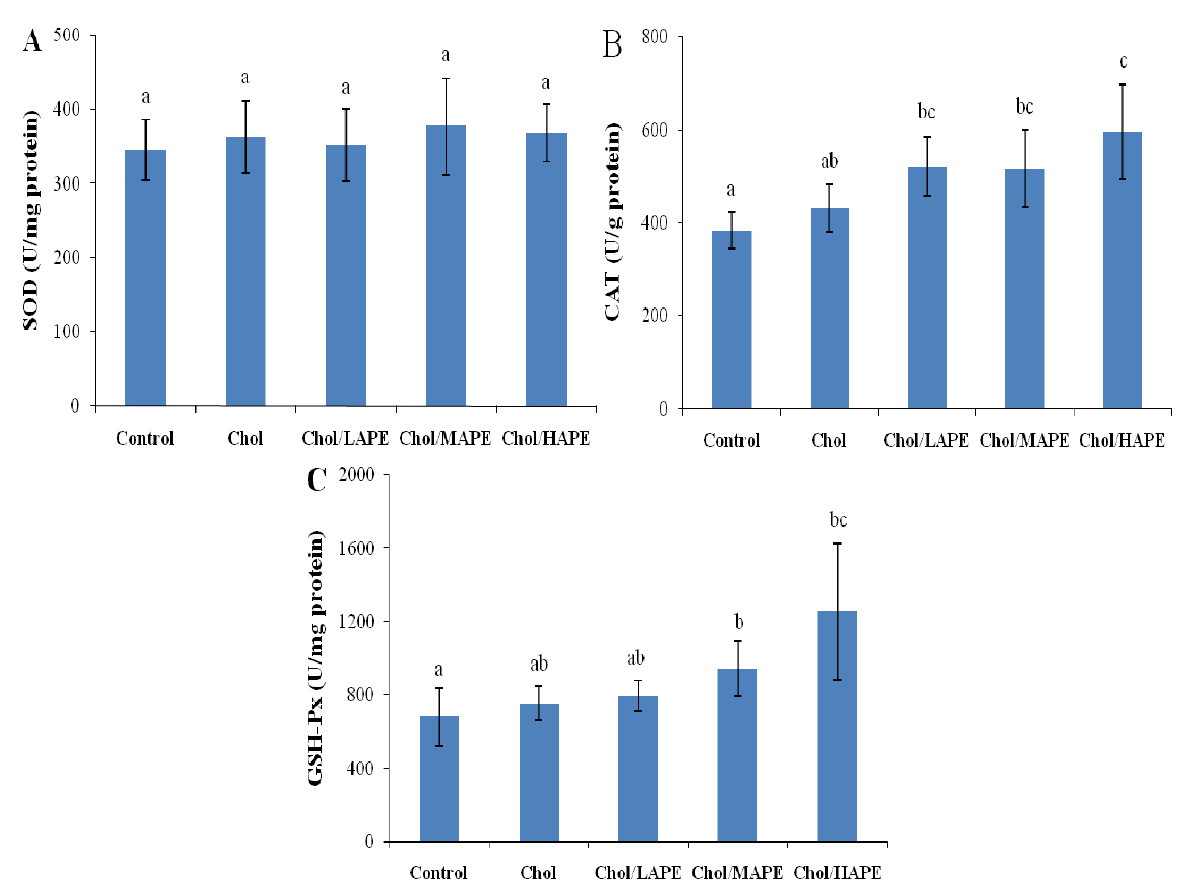
Figure 3. Effect of APE on hepatic SOD, CAT, and GSH-Px activities in rats. Values are expressed as mean ± SD. Bars not sharing common letter superscripts are significantly different ( p < 0.05).